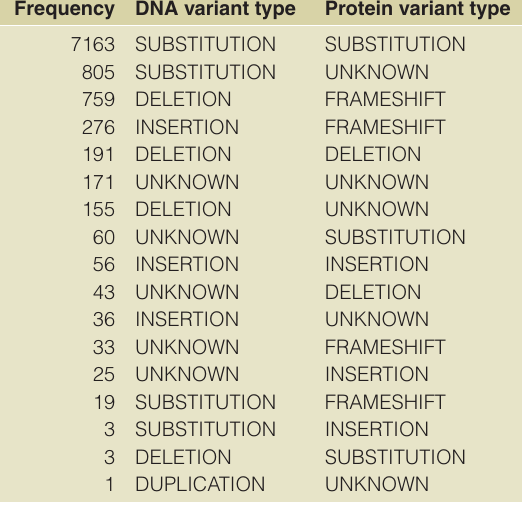
Table 19. InSiGHT missing variants by the combination of variant extraction tools grouped by type, taking into account the DNA variant and the impact on the gene product. Missing variants have been annotated using SETH, thus the variant types delivered by SETH are considered.